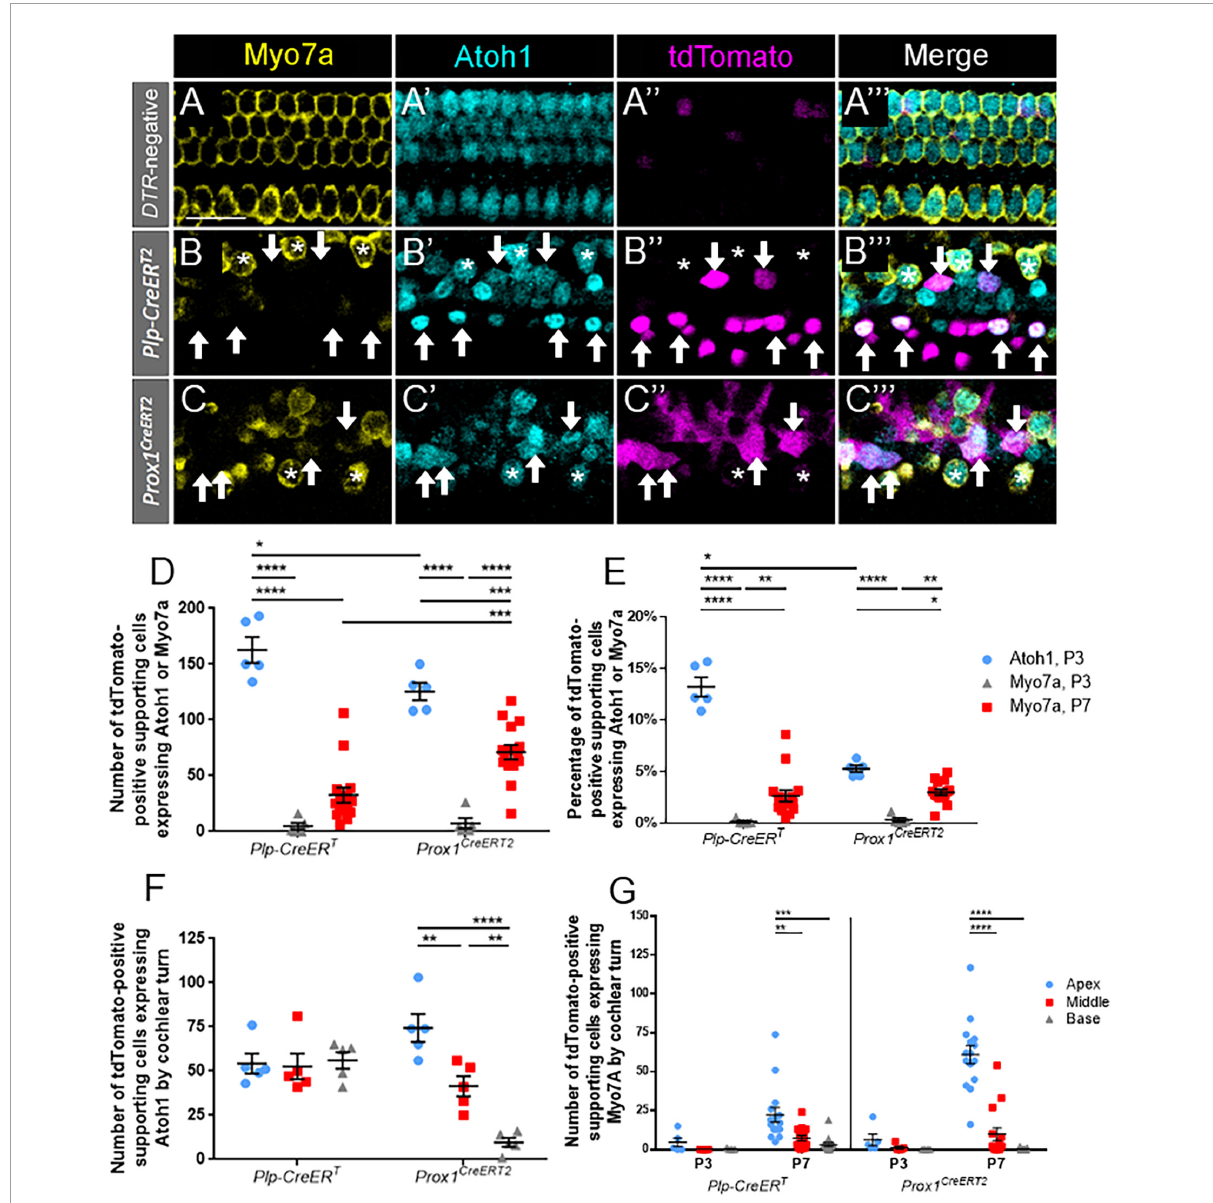
FIGURE2 A significant proportion of Atoh1-positive supporting cells at P3 do not mature to Myo7a-positive regenerated hair cells by P7. (A–C”’) Representative confocal slice images from the apical turn of Atoh1 GFP / + (A–A”’) , Plp-CreER T :Rosa26 tdTomato :Pou4f3 DTR :Atoh1 GFP / + (B–B”’) and Prox1 CreERT 2 :Rosa26 tdTomato :Pou4f3 DTR :Atoh1 GFP / + (C–C”’) mice at P3. All mice were injected with tamoxifen at P0 to induce tdTomato expression in various groups of supporting cells and with DT at P1 to induce hair cell damage. Samples were immunostained with anti-Myo7a antibodies (yellow) to label all hair cells and anti-GFP antibodies (blue) to detect Atoh1 expression as an early marker of hair cell conversion. tdTomato was detected using endogenous fluorescence (magenta). Arrows indicate Atoh1-positive/Myo7a-negative/tdTomato -positive fate-mapped supporting cells. Asterisks indicate Myo7a-positive/tdTomato-negative cells that are hair cells which survived the DT-mediated damage. Note that in controls all Atoh1-postive cells also expressed Myo7a. Scale bars: 25 µ m. (D) The supporting cell populations fate-mapped by Plp-CreER T produced significantly more cells expressing Atoh1 than those fate-mapped by Prox1 CreERT 2 . A significant number of the hair cell progenitors from both populations of supporting cells did not mature to Myo7a-positive regenerated hair cells by P7, although the number of Myo7a-positive regenerated hair cells present at P7 was significantly greater for in the Prox1 CreERT 2 group compared the Plp-CreER T group. (E) Data from panel (D) normalized to the total number of Tomato-positive supporting cells in each mouse model. (F) When stratified by cochlear turn at P3, there were similar numbers of Atoh1-positive, Plp-CreER T -positive supporting cells in each turn, but there was a decreasing gradient of Atoh1-positive, Prox1 CreERT 2 -positive supporting cells from apex to base. (G) Supporting cell populations in both CreER lines produced significantly more regenerated hair cells in the apex compared to the middle and basal turns at P7, but there were no differences across cochlear turns at P3. Data are presented as mean ± SEM for n = 5–15. * p < 0.05; ** p < 0.01; *** p < 0.001; **** p < 0.0001 determined using two-way ANOVA with a Sidak’s post-hoc